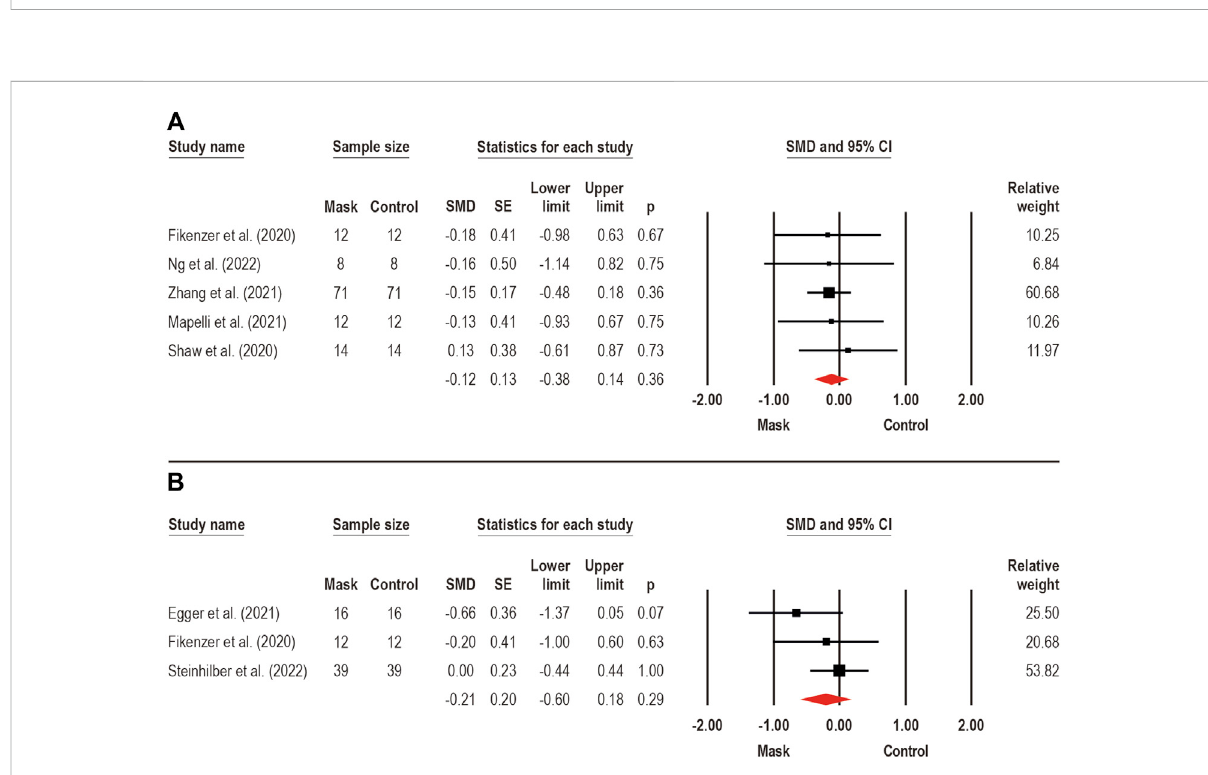
FIGURE 6 Acute effects of face mask vs. control (unmasked condition) on maximal power output (PO MAX ) performance. Forest plots with pooled standardized mean difference (SMD), standard errors (SE), and 95% con fi dence intervals (CI) are displayed: (A) analysis of face mask wearing effects on PO MAX by absolute values (W) (SMD: − 0.12; 95% CI − 0.38 to 0.14; p = 0.36; I 2 = 0%); (B) analysis of face mask wearing effects on PO MAX by body mass relative values (W/kg) (SMD: − 0.21; 95% CI − 0.60 to 0.18; p = 0.29; I 2 =